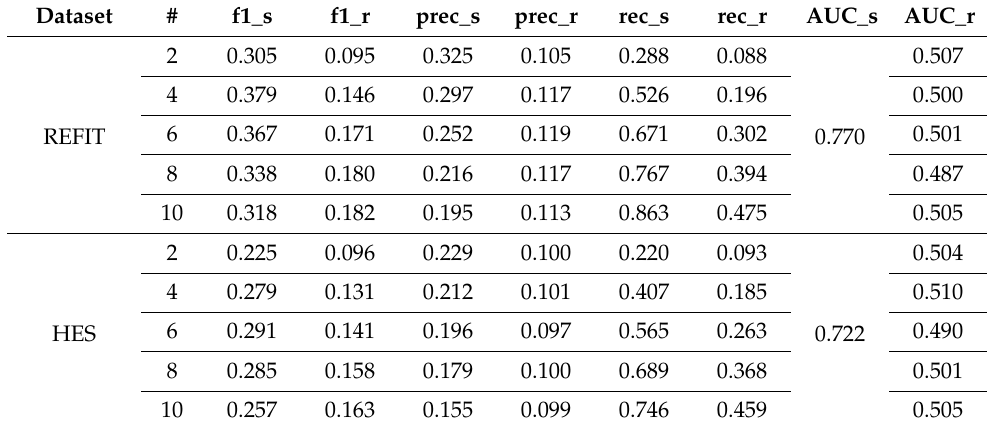
Table 1. Workday/non-workday-single appliance (washing machines). Throughout the rest of the tables, the sign # refers to the pre-specified number of households in which the system sends the